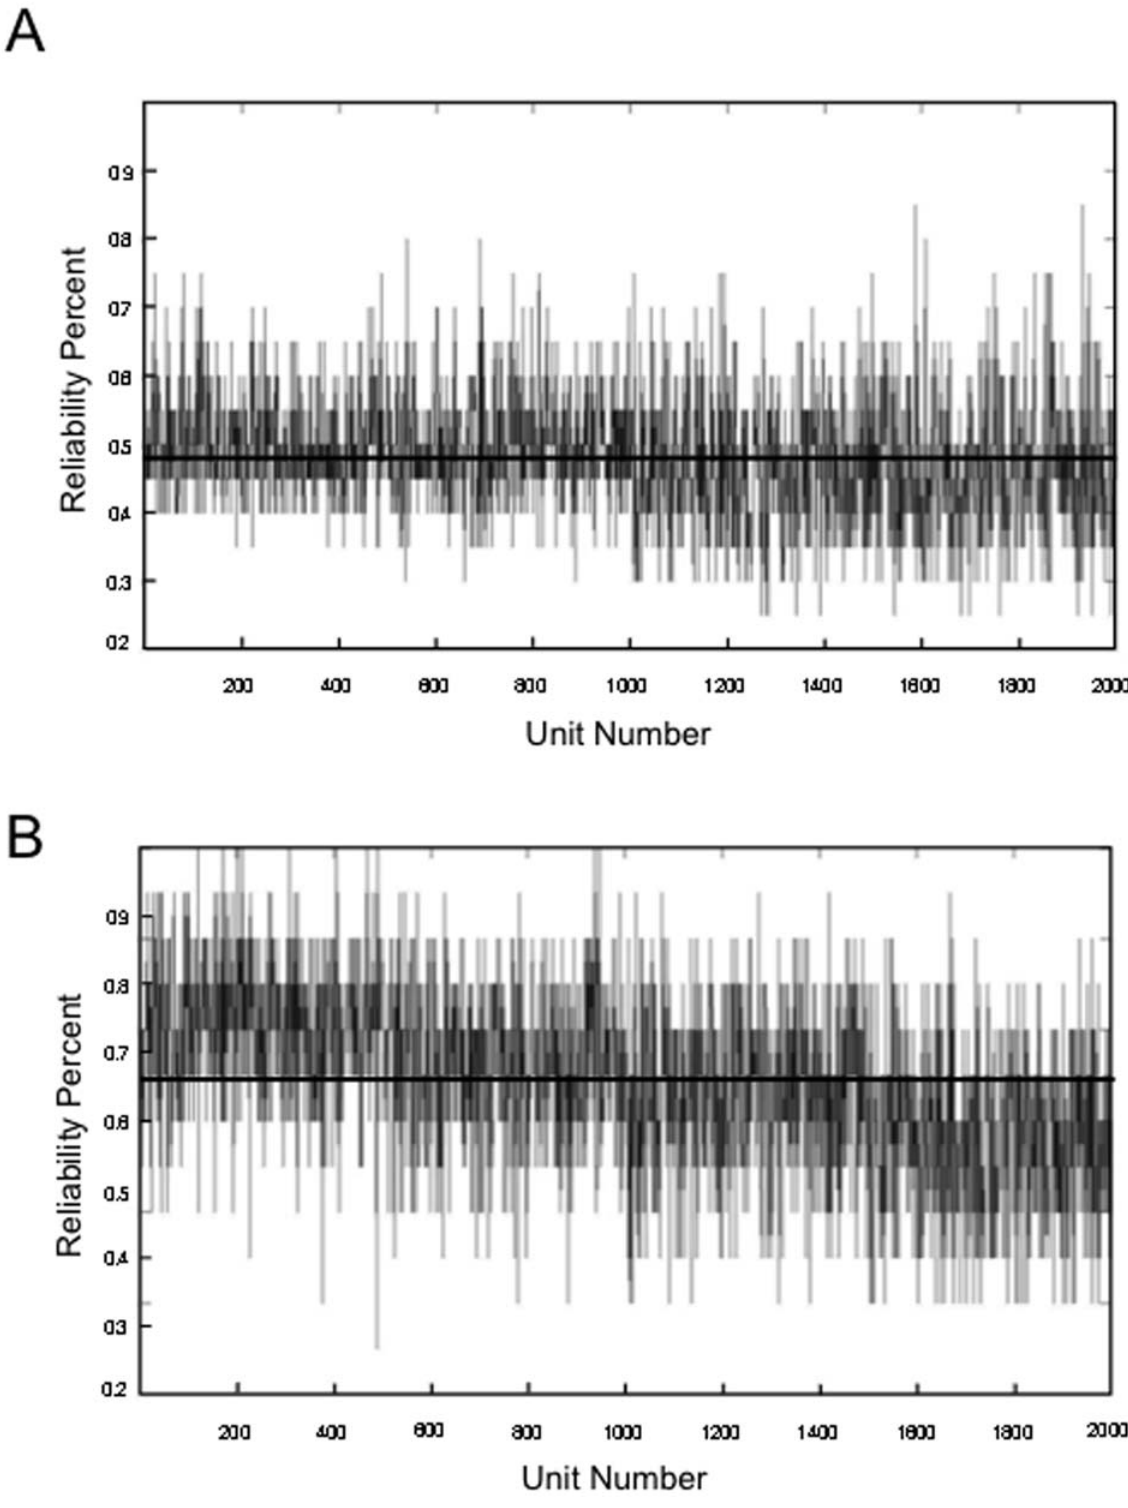
Figure 13. Reliability of units in the 2000 unit networks for exhibiting from trial to trial the pattern indicated by each unit’s average PSTH histogram. A) Reliability of each unit in the 2-population, 2000 unit network. The average reliability (percentage of trials exhibiting the pattern observed in the average PSTH histogram) ranges from approximately 40–100% of trials, with an average of approximately 47%. This is similar to that observed for the 200 unit 2- and 4- population spiking models. B) Reliability of each unit in the 4-population, 2000 unit network. The average reliability is significantly higher across all 2000 units (approximately 75%) although the range of variability of individual units is similar to that observed in each of the previous networks. These reliability values are similar to that observed in the real cortical data of parietal and prefrontal cells.